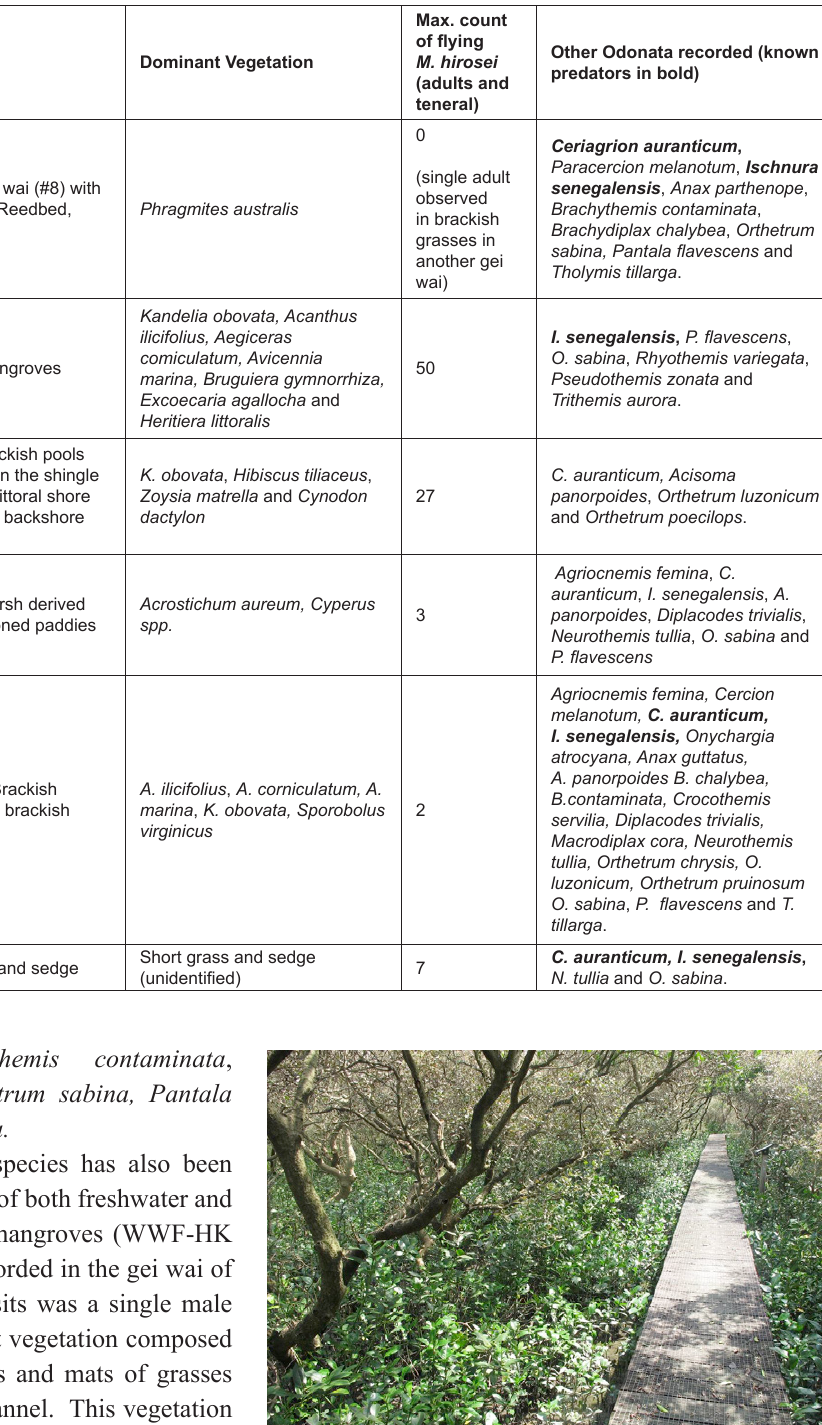
Table 1. Summary of vegetation and Odonata at locations surveyed in